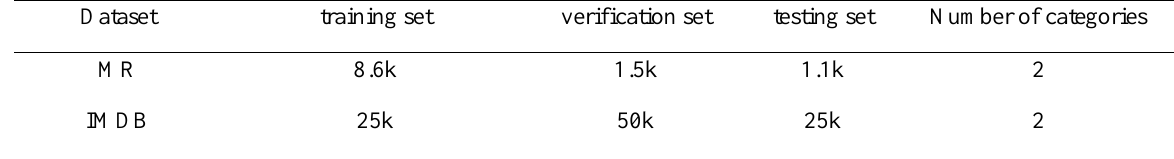
Table 1. Experimental data set